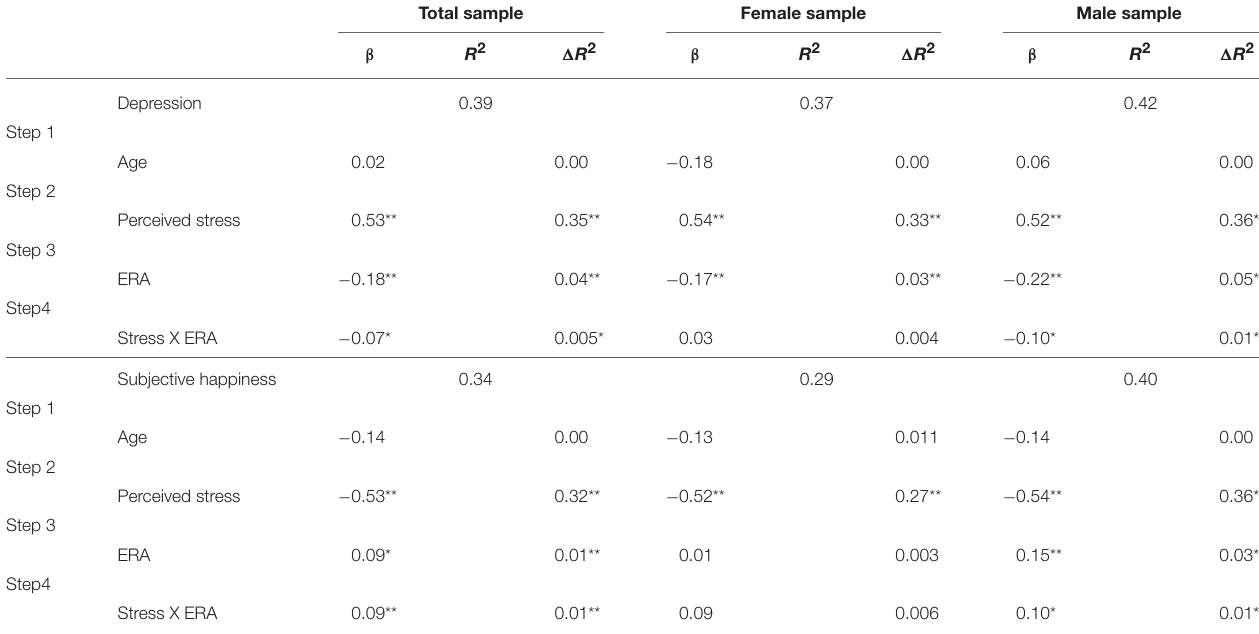
TABLE 3 | Regression results for the moderating effect of perceived stress and ERA on depression and happiness for total, female and male sample.